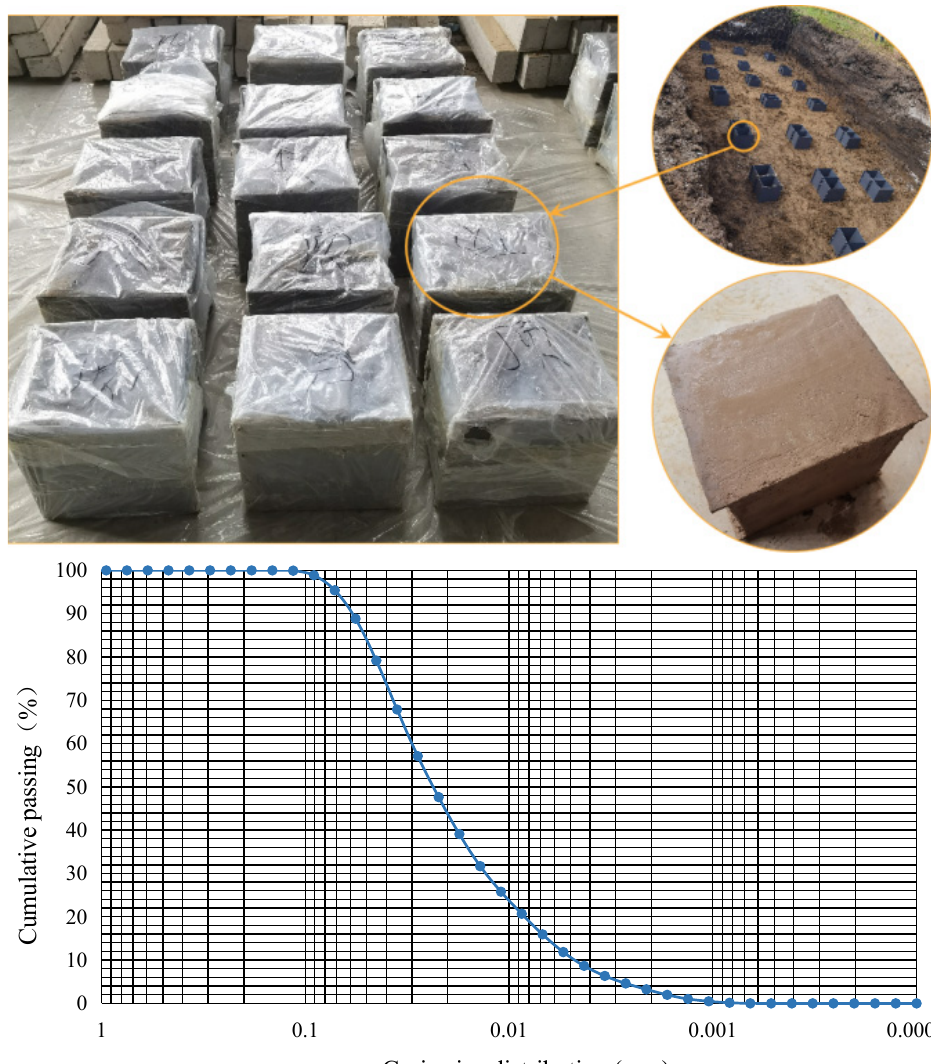
Figure 1. Undisturbed soil retrieved from the site and its grain size distribution curve. Table 1. Basic parameters of undisturbed soil.